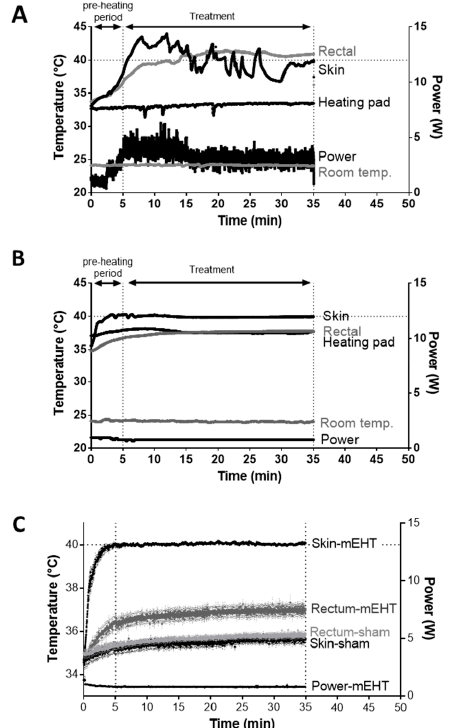
Figure 1. Comparison of LabEHY-100 tissue electrode and LabEHY-200 pole electrode. ( A ) LabEHY-100 with tissue electrode: skin-, rectal-, heating pad- and room-temperatures and applied power during treatment. Representative recording from 1 treatment; ( B ) LabEHY-200 with pole electrode: skin-, rectal-, heating pad-, and room-temperatures and applied power during treatment. Representative recording from 1 treatment; ( C ) temperature recordings from 12 mEHT and 12 sham treatments with LabEHY-200 and pole electrode. n = 12 / group, Mean ±